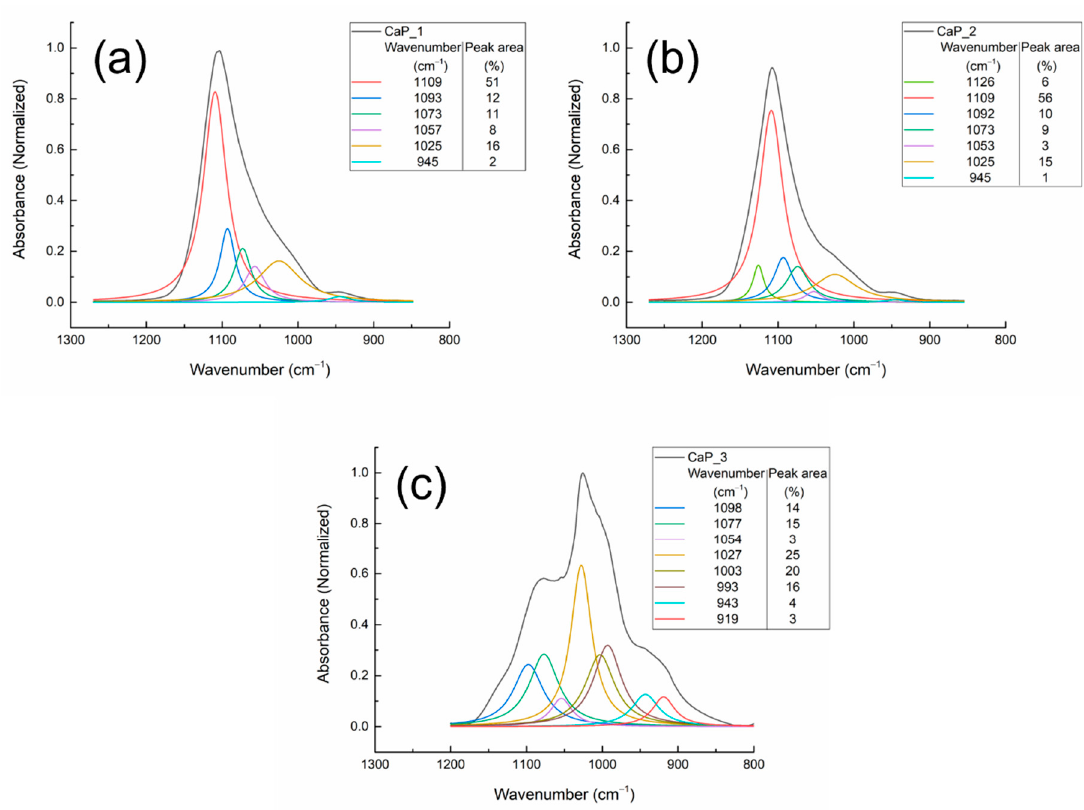
Figure 10. Deconvoluted FTIR spectra of the CaP coatings deposited at different substrate temper- atures: ( a ) CaP_1, ( b ) CaP_2, and ( c ) CaP_3 in the 1300-800 cm − 1 wavenumber range. tures: ( a ) CaP_1, ( b ) CaP_2, and ( c ) CaP_3 in the 1300–800 cm − 1 wavenumber